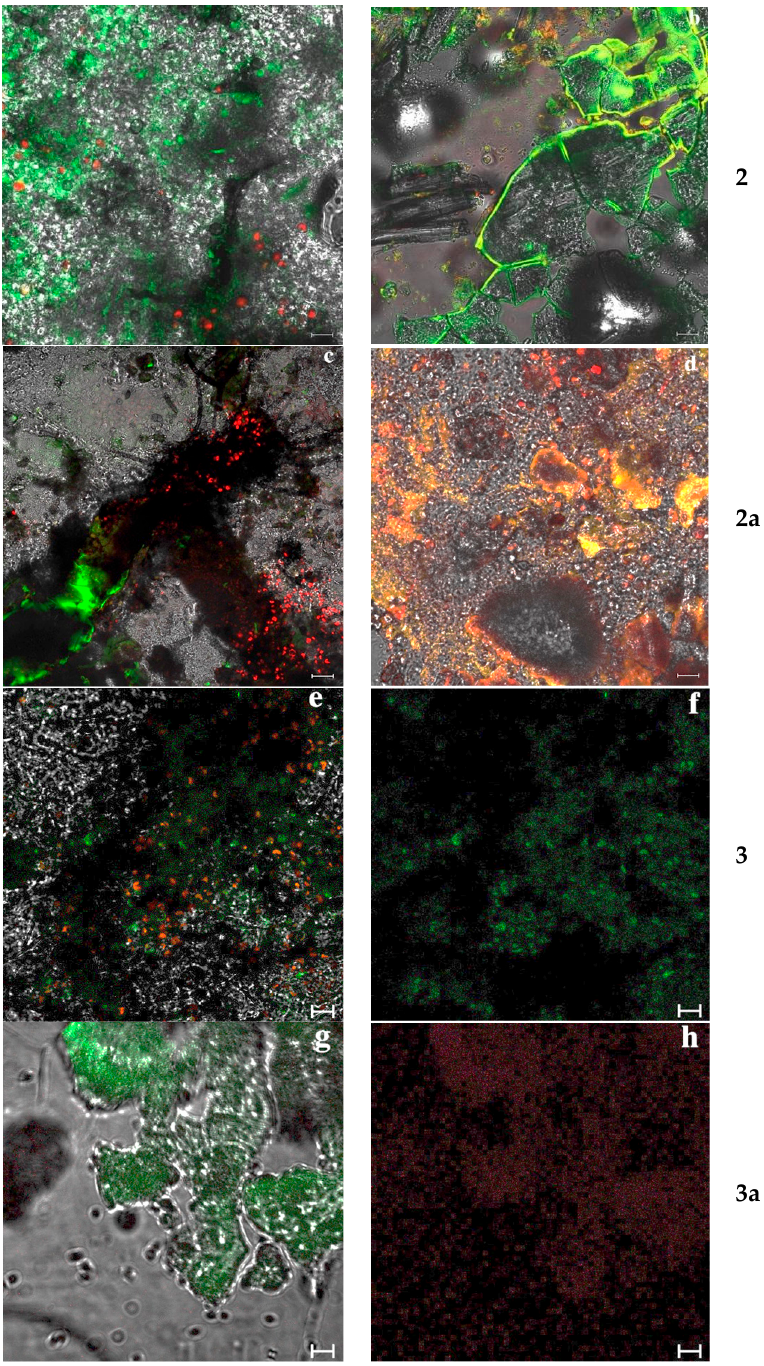
Figure 5. Biofilm behavior on tufa after incubation for 90 days, related to the coating treated with compounds 2 , 2a , 3 and 3a . Inner and outer layers showed a diverse arrangement of microbial members of the biofilm. The different groups are well recognizable being algae colored in red, bacteria in green, while black fungi appear as black areas between the colored cells.Outer and inner layers of biofilm: ( a , b ) in the areas treated with 2 ; ( c , d ) in the treated with 2a ; ( e , f ) on areas treated with 3 ; ( g , h ) residues of the coating and very few cells are observed on areas treated with 3a. Detailed explanations are given in the text. Bar is 10 μ m.